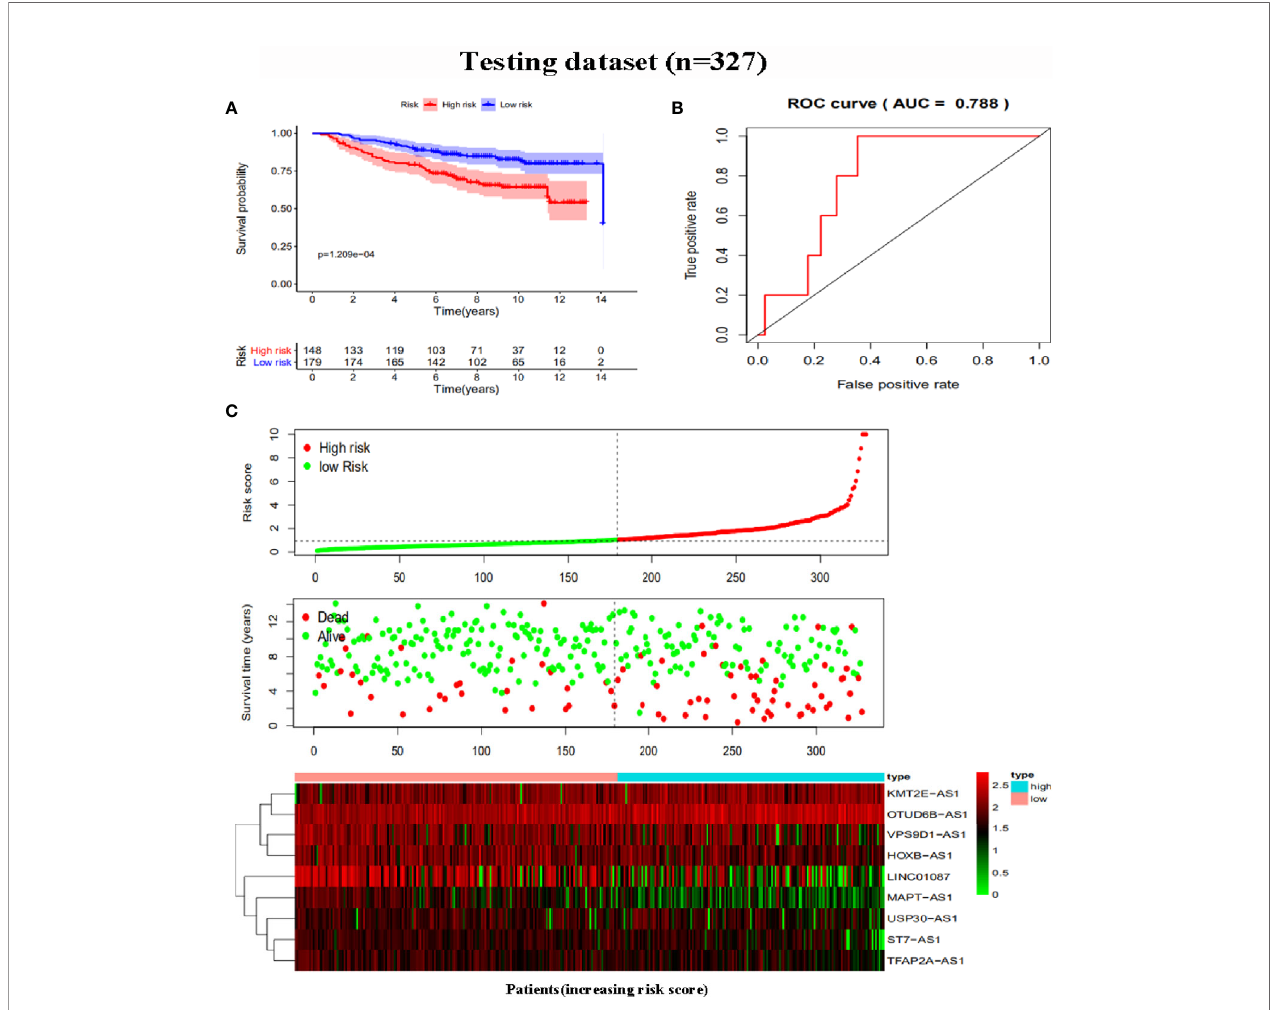
FIGURE 5 | Risk score analysis of the prognostic signature in the testing dataset. (A) Kaplan-Meier survival for low-risk group and high-risk group. (B) ROC curves for predicting OS based on risk score. (C) Risk score distribution, survival status, and expression heat map.